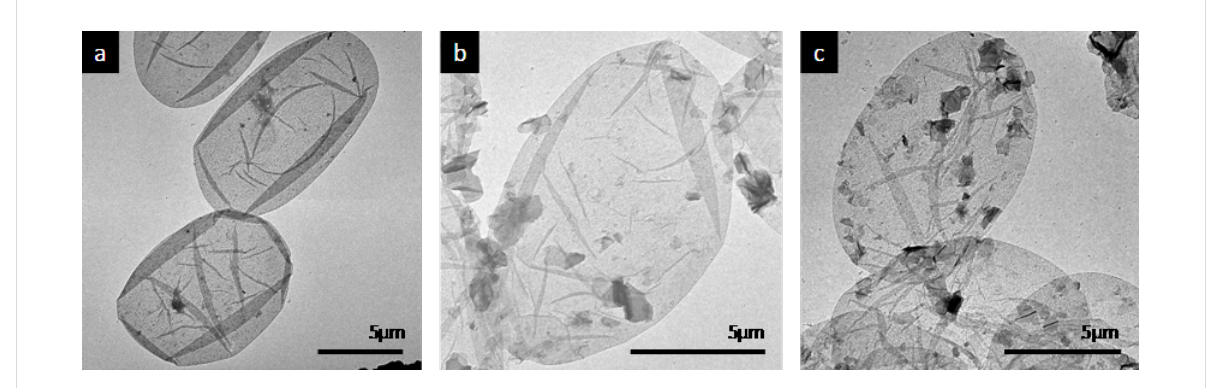
Figure 3: TEM micrographs of a) sample 1: (PSS/PAH) 4.50.5M , b) sample 2: (PSS/PAH) 20.5M + [GO/(PAH/PSS/PAH) 0.5M /GO] + (PSS/PAH) 0.5M , c) sample 3 (PSS/PAH) 20.5M + [GO/PAH] 2.5 + (PSS/PAH) 0.5M using a concentration of 0.1 mg/mL of GO during the assembly.